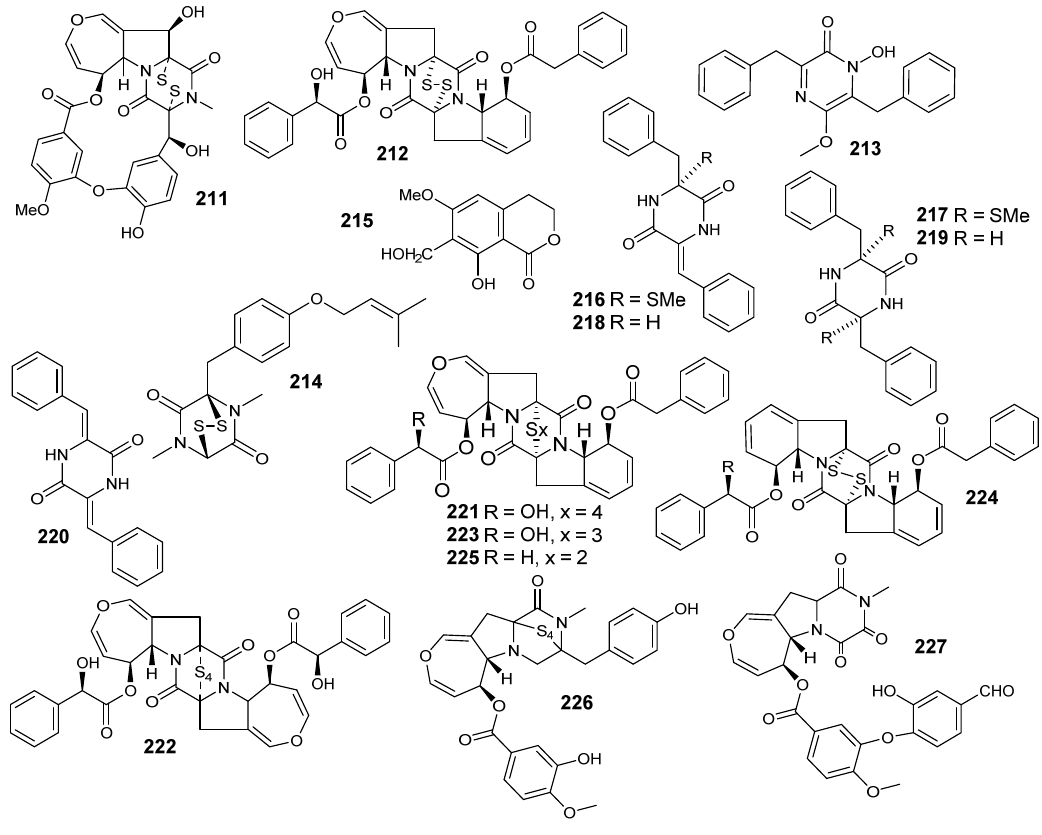
Figure 14. Structures of compounds 211–227.